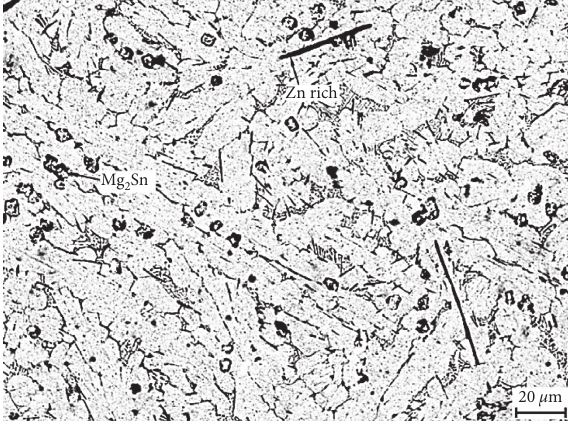
Figure 2: Microstructure of the Sn